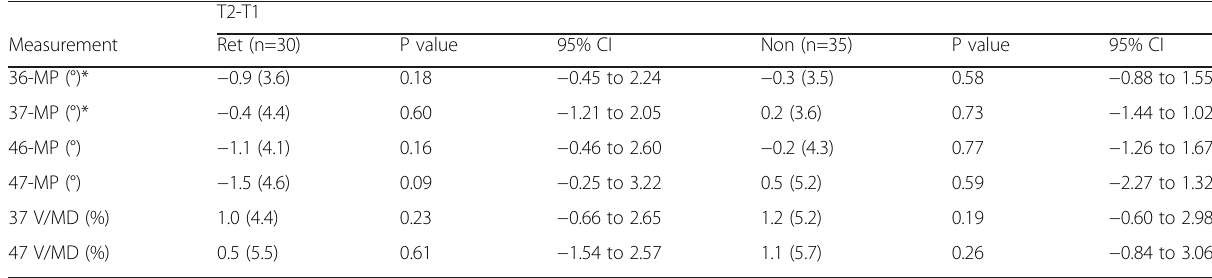
Table 3 Means, SD in parentheses of the molar inclination angles and movement percentages between T1 and T2, and P values, 95% CI of intragroup differences (paired t-test): Ret, retention group; Non, non-retention group; *, Wilcoxon signed-rank